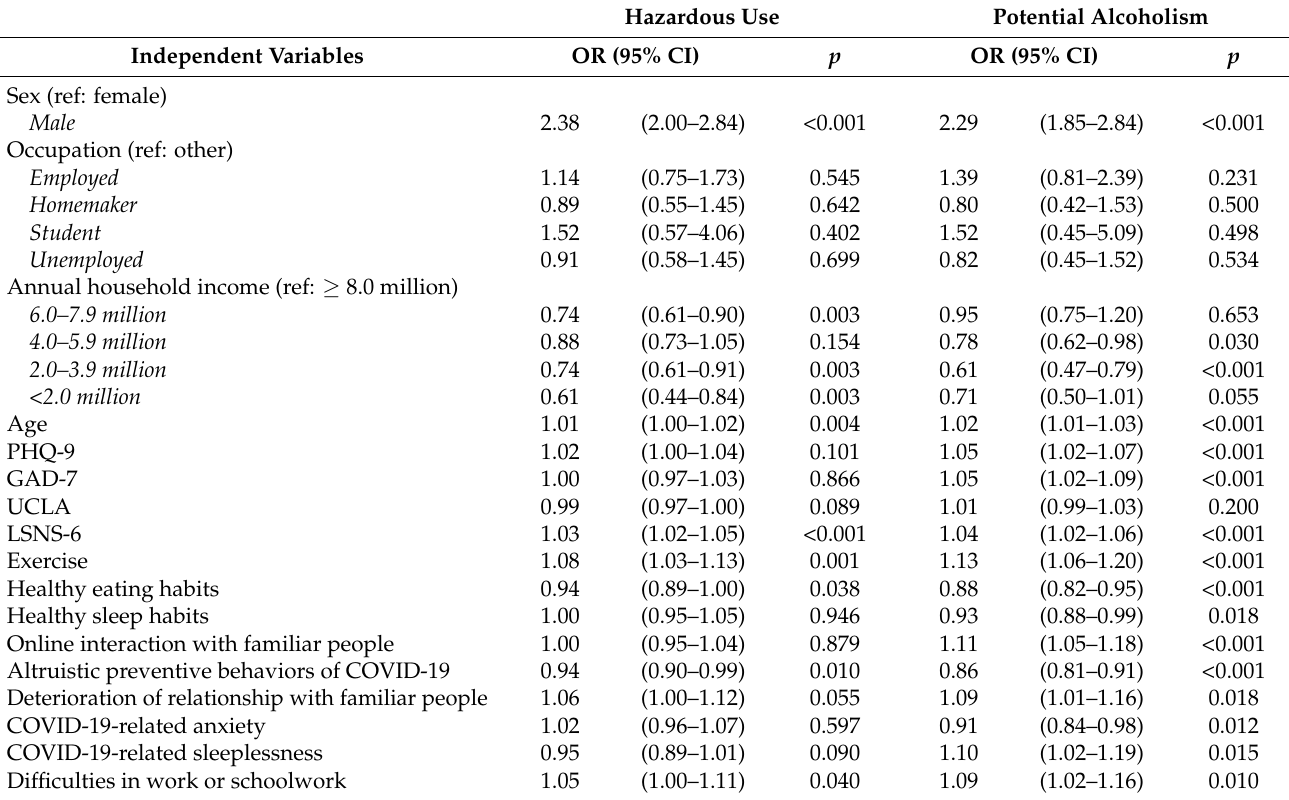
Table 6. Results of multinomial logistic regression